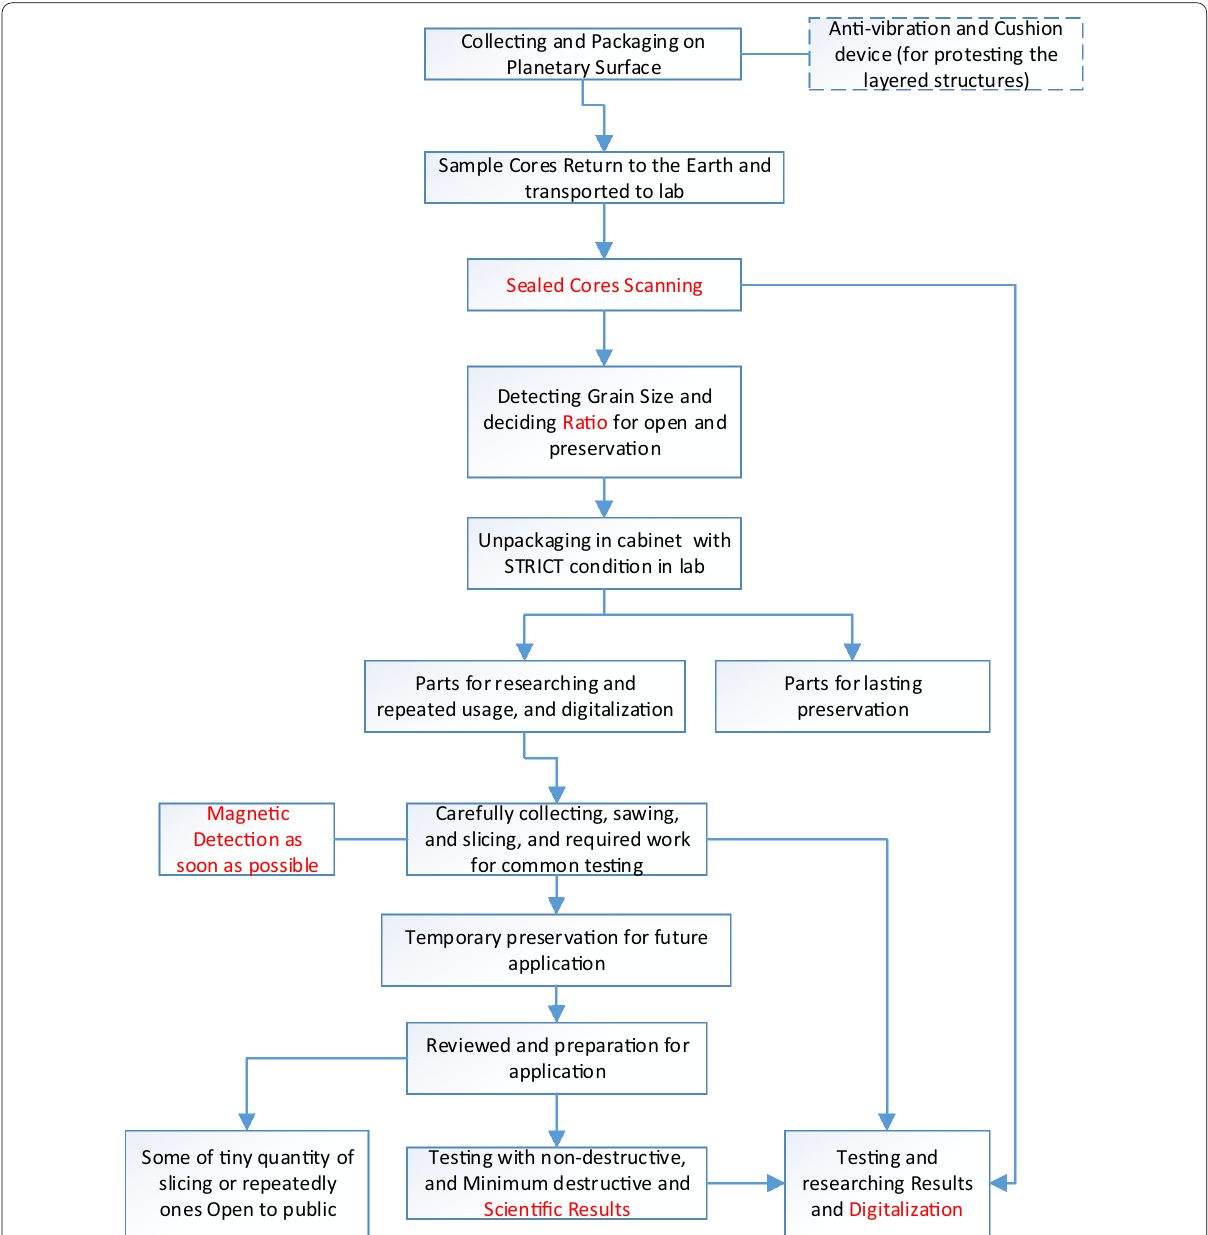
Fig. 4 Flowchart of the returning processing, preservation, and public announcement of samples collected from the Chang’e-5 or possible from extra-terrestrial missions (the words in red indicate steps that are significant during the process of sample preservation and/or processing of the Chang’e-5